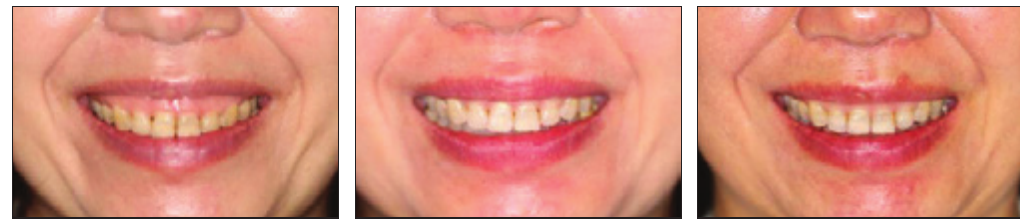
Figure 9. Full smile before lip repositioning procedure, one-year follow-up and two-year follow-up after the